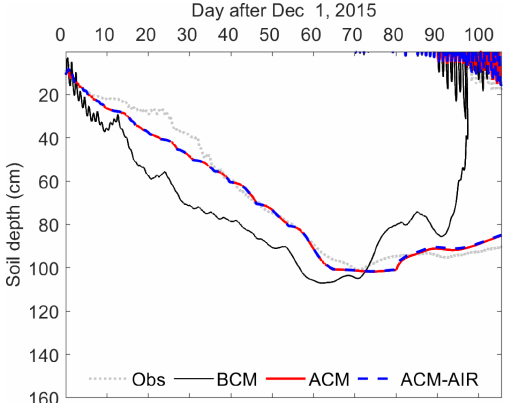
Figure 4. Comparison of measured (Obs) and model-simulated freezing front propagation (FFP) using the basic coupled model (BCM), advanced coupled model (ACM), and advanced cou- pled model with airflow (ACM–AIR). Note that the measured FFP was seen as the development of zero degree isothermal lines from the measured soil temperature